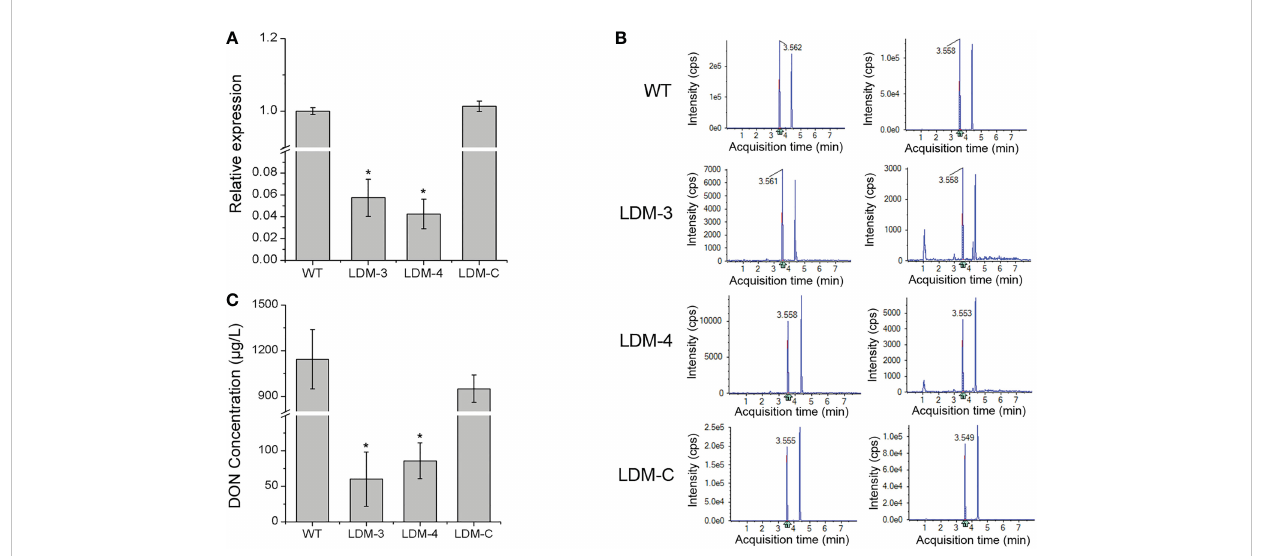
FIGURE 7 Transcription level of the TRI5 gene and DON concentration in inducing medium. (A) Relative transcript abundances of the TRI5 gene in mycelium in inducing medium were compared between the wild-type and FpLaeB mutant strain at 7 dpi. Cycle threshold of the FpActin gene was used to normalise different samples. Expression levels of wild type were arbitrarily given a value of 1. (B) UPLC-MS/MS chromatogram of DON at inducing media of different strains. (C) DON concentration of different strains cultured in inducing medium for 14 days. Mean and standard deviation of data were calculated from three biological replicates. Statistical analysis was performed using Fisher ’ s LSD in